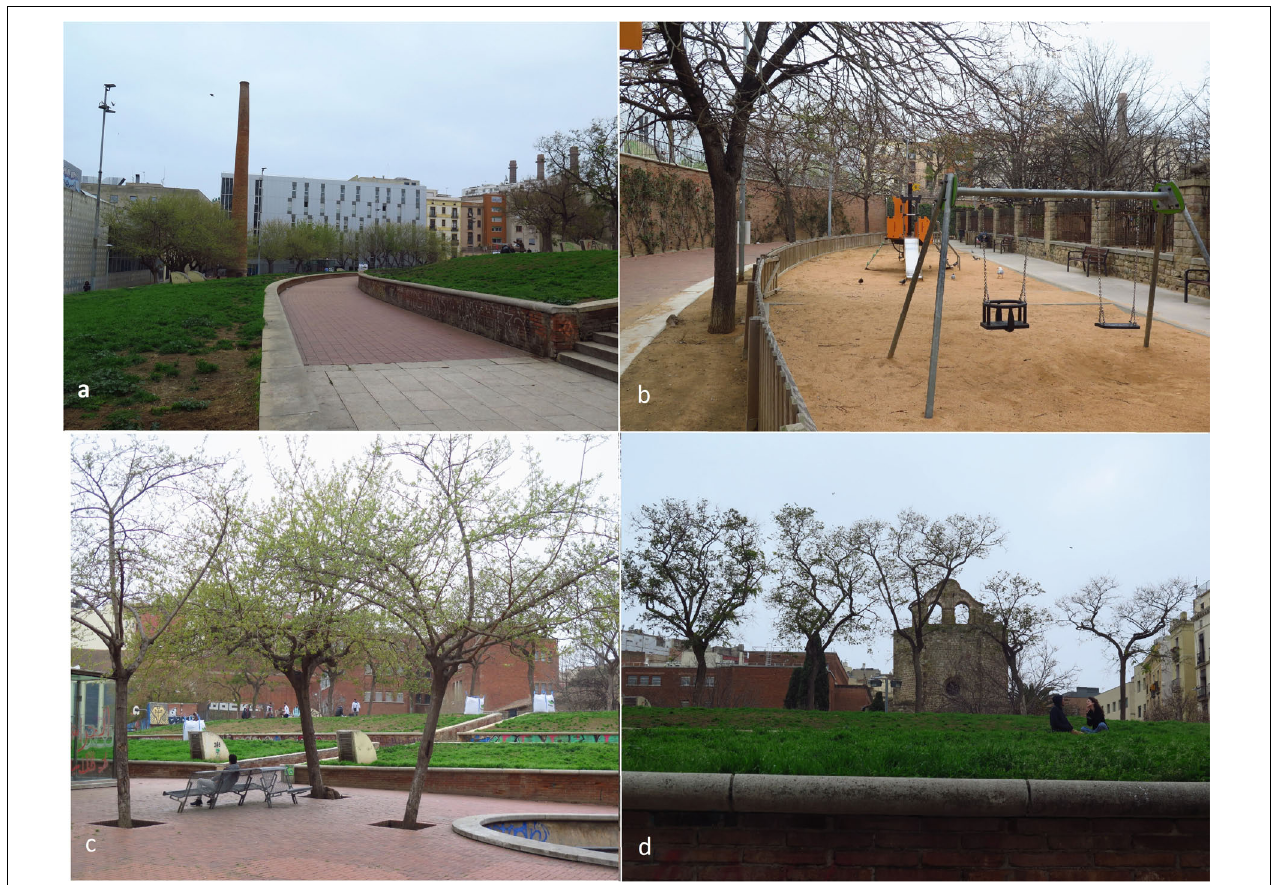
FIGURE 1 | St. Pau del Camp Gardens, (a) Passage zone with the chimney of the old factory; (b) Playground area located in the lowest level of the park; (c) Resting area, located near the sport court; and (d) Artificial hills surrounding the Romanesque monastery of St. Paul in the Fields. Source: Authors.